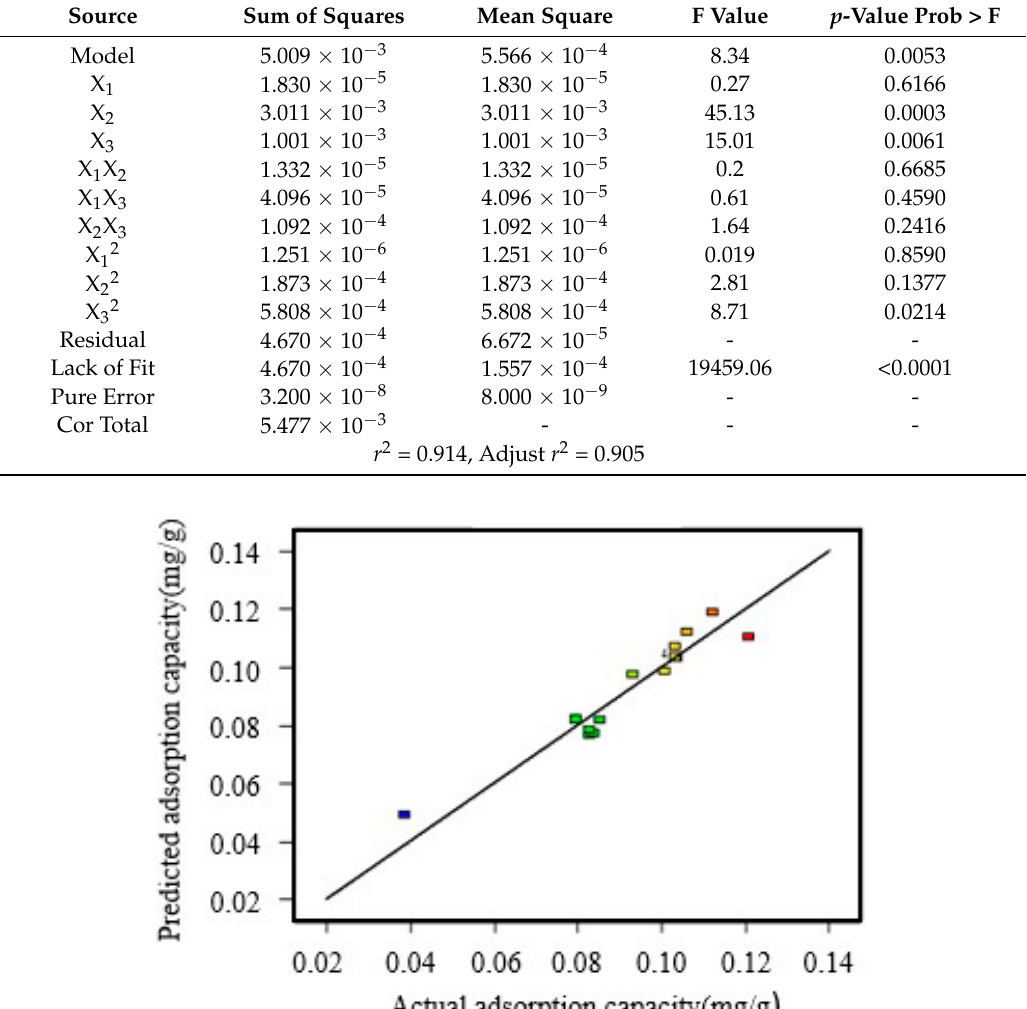
Figure 10. The regression plots of the actual data against the predicted values from the response surface models describing. models